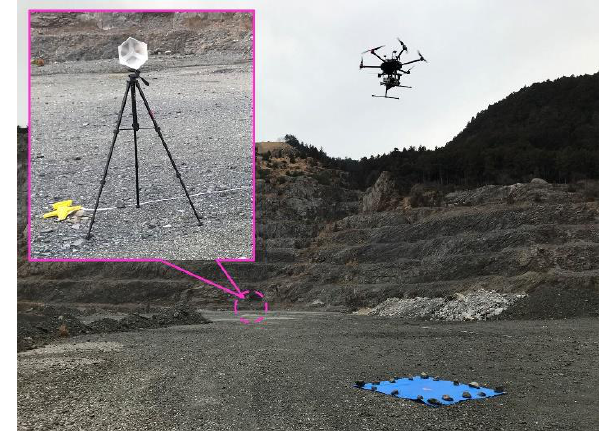
Figure 9. Data acquisition test targeting a corner reflector